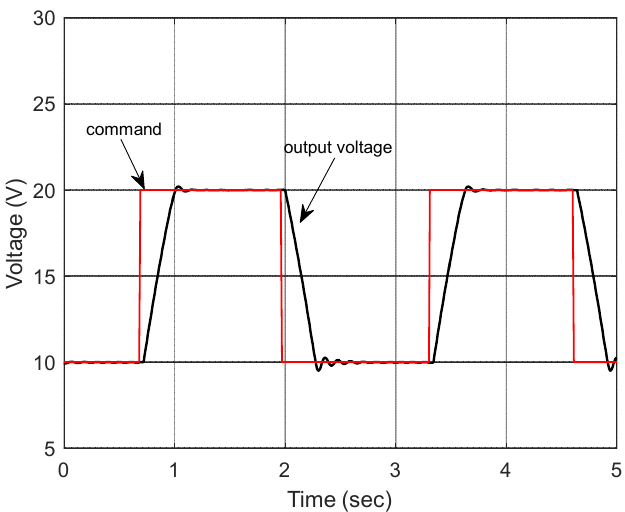
Figure 20. Experimental results for voltage regulation.